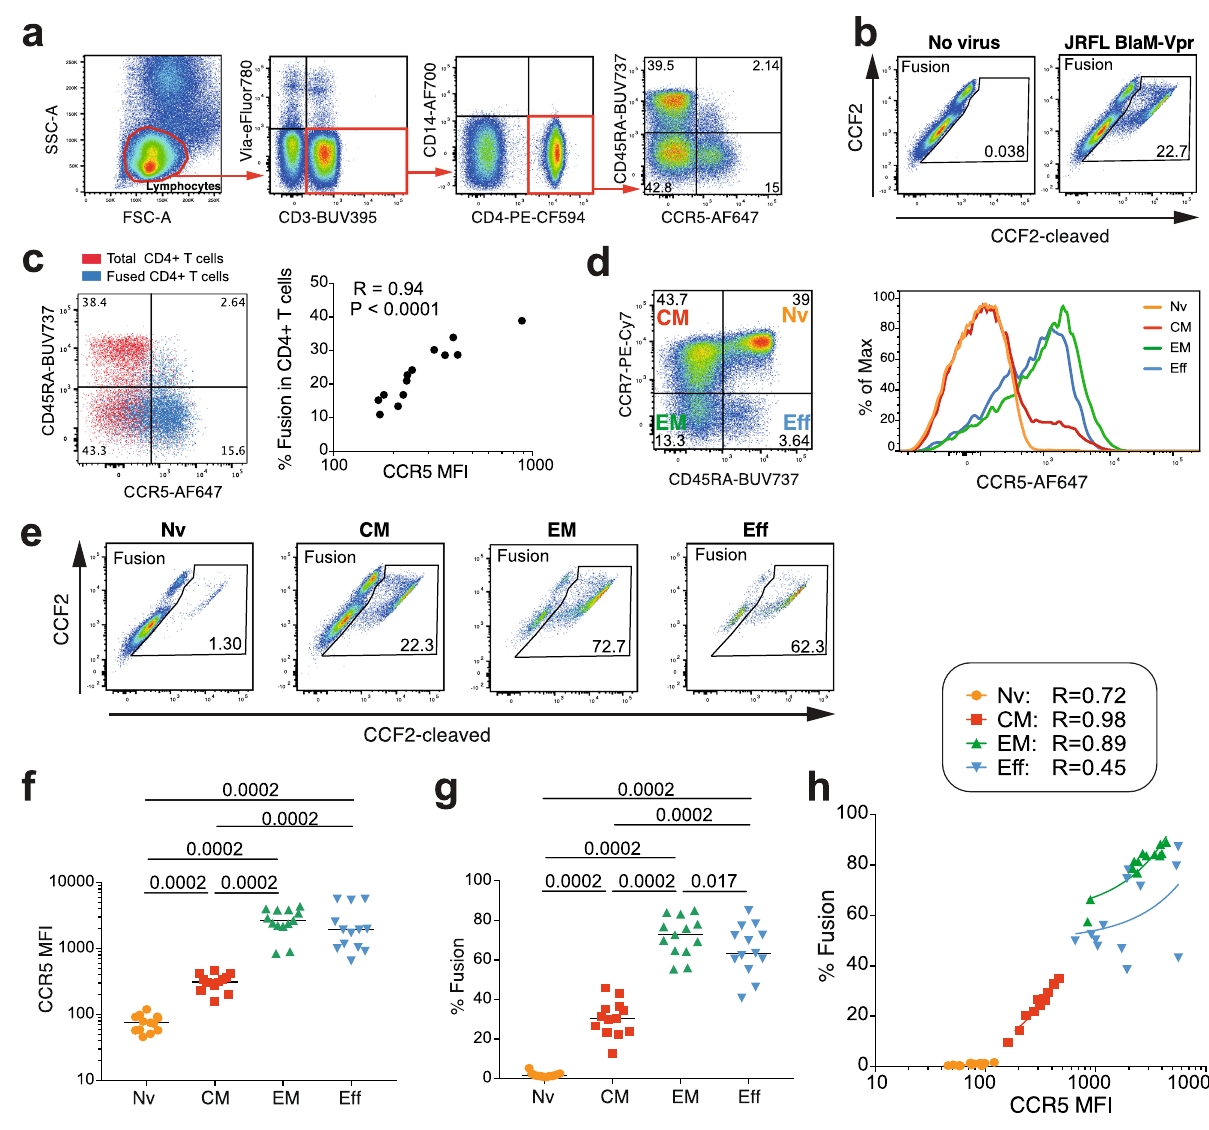
primary CD4 + T cells from healthy donors (HD, n = 13). a Gating strategy for the analysis of HIV-1 fusion in CD4 + T cells. b Example of HIV-1 fusion in HD CD4 + T cells, as measured by the cleavage of the fl uorescent FRET substrate CCF2. c Overlay plot illustrating that HIV-1 JR-FL fusion occurs predominantly in CCR5 + cells (left) and association between CCR5 expression (MFI) and fusion in HD CD4 + T cells (right). The Pearson correlation coef fi cient R is reported. d CCR5 expression in CD4 + T cell subsets from one HD. Naive (Nv), central memory (CM), effector memory (EM), and effector (Eff) subsets de fi ned by CD45RA and CCR7 expression (left) show different CCR5 expression levels (right). e Example of HIV-1 JR-FL fusion in the 4 CD4 + T cell subsets. f , g Quantitation of CCR5 expression ( f ) and HIV-1 JR-FL fusion ( g ) in the 4 CD4 + T cell subsets. Signi fi cant differences between medians were computed with the Mann-Whitney test. h Correlations between CCR5 expression and HIV-1 JR-FL fusion in the 4 CD4 + T cell subsets. Pearson linear correlation coef fi cients are reported. Nv Orange circles, CM Red squares, EM Upward green triangles, Eff Downward blue